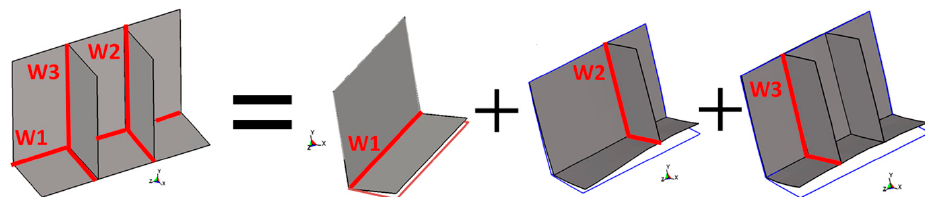
Figure 1. Analyzing sequence of arc welding induced deformation with the aid of inherent strain method.